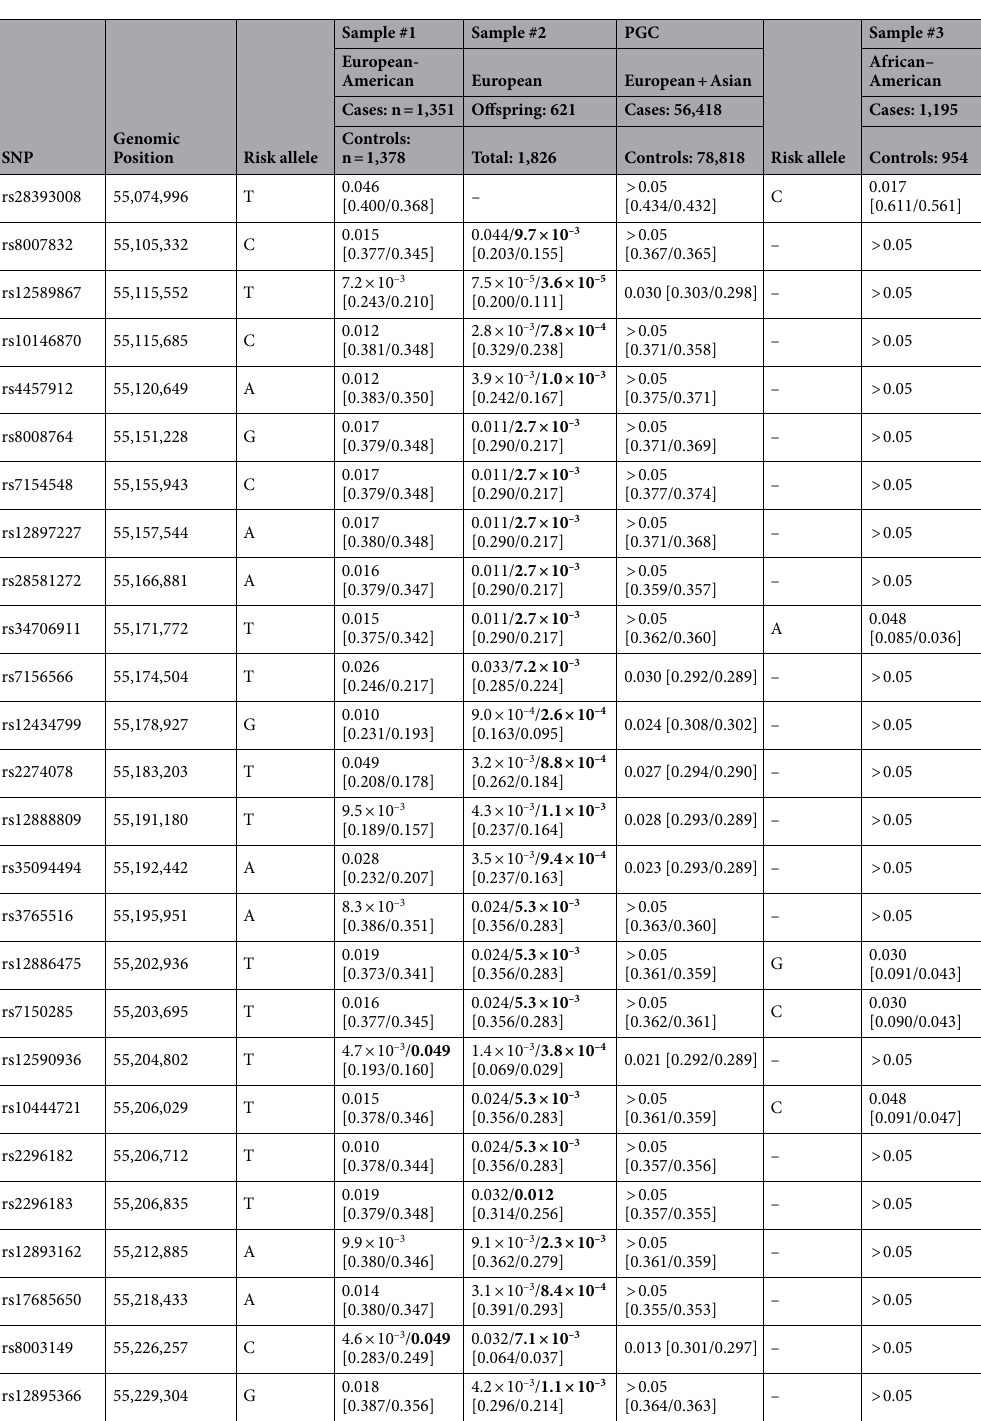
Table 1. p/q [allelic frequency] values for associations between KTN1 SNPs and schizophrenia in four samples. “– “, omitted alleles with p > 0.05. “–”, missing. The bold values indicate q < 0.05. The values in “[]” are allelic frequencies in cases/controls or transmitted/untransmitted. PGC, psychiatric genomics consortium. Risk alleles are minor alleles ( f < 0.5) in Europeans but major alleles ( f > 0.5) in